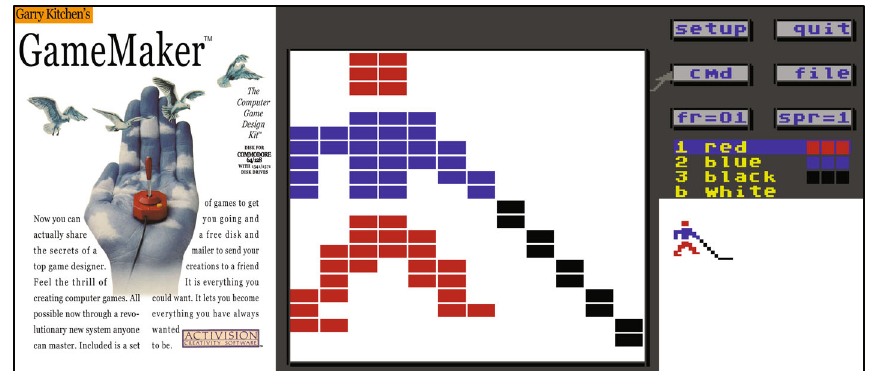
Figure 1: Cover and sprite editor tool from Garry Kitchen ’ s Game Maker.